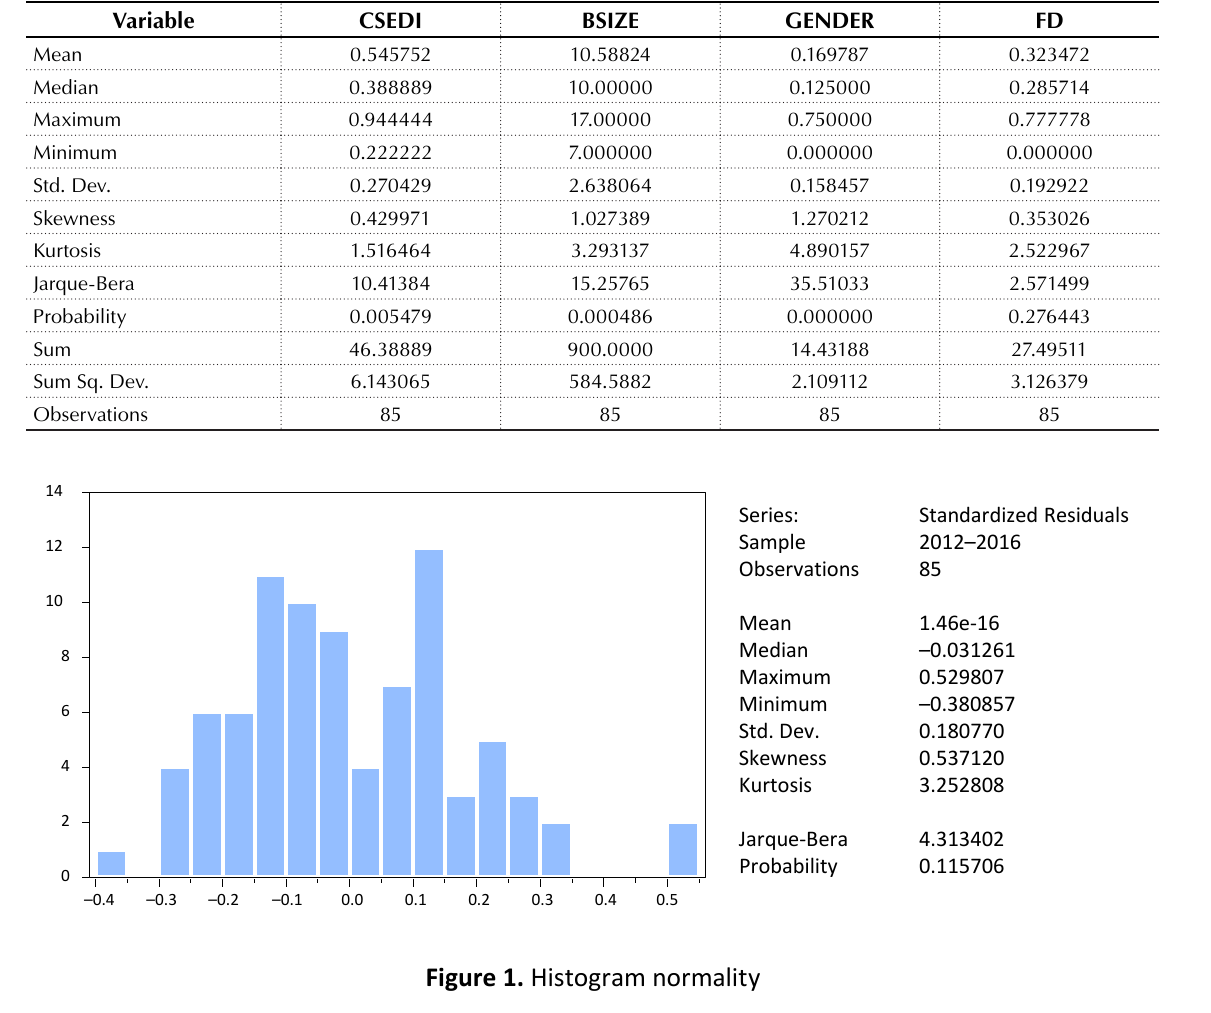
Source: Calculated by the researchers using the E-VIEWS 9 (2016).